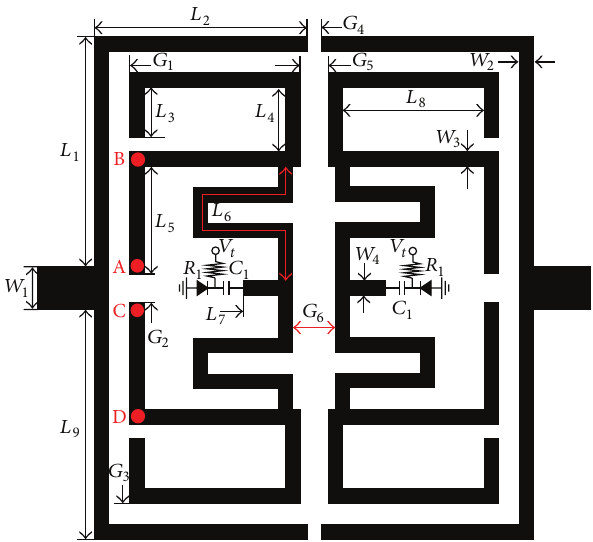
Figure 3: Structure of the proposed tunable dual-band filter.